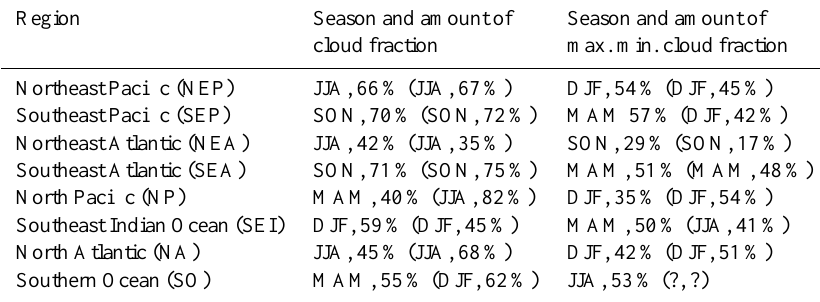
Table 2. Low-cloud statistics derived from 5 years of combined CloudSat/CALIPSO observations. The seasons and cloud fractions given in parentheses are taken from Klein and Hartmann (1993) for